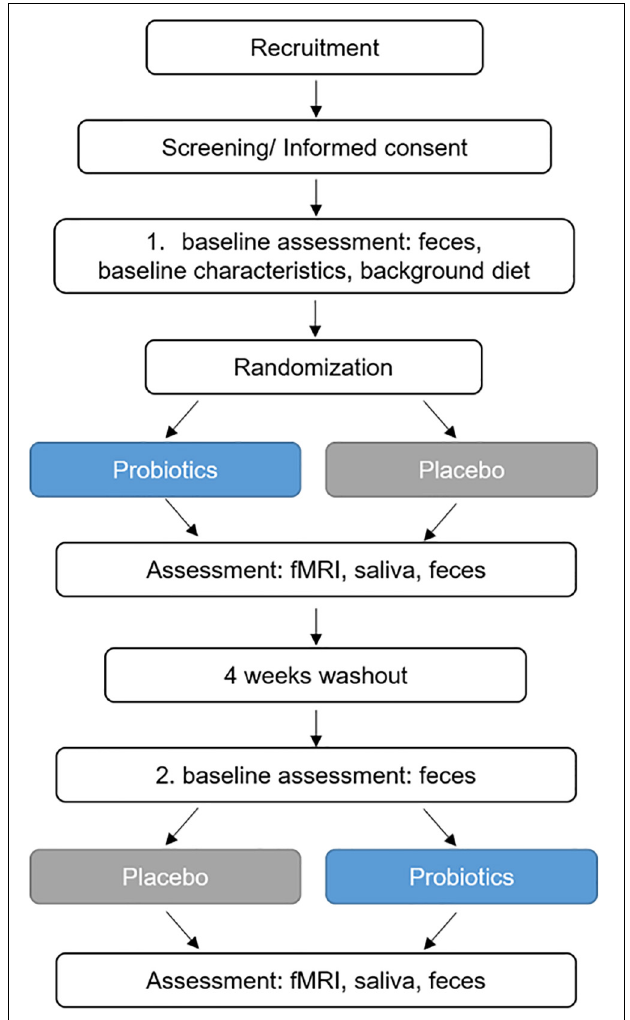
FIGURE 1 | Study design. fMRI, functional magnetic resonance